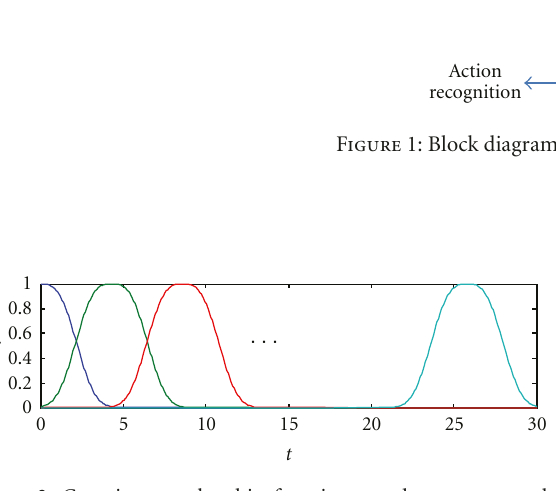
Figure 2: Gaussian membership functions used to represent the temporal intervals, with ε j = { 0,4,8, ... } , σ = 2, and m = 3.